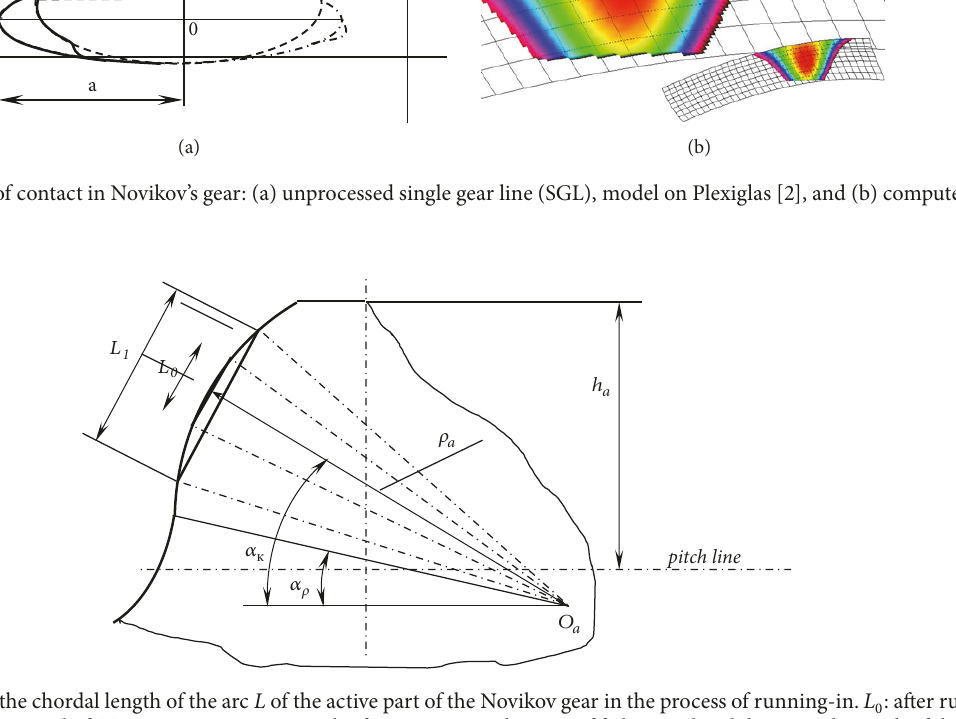
Figure 2: Changing the chordal length of the arc L of the active part of the Novikov gear in the process of running-in. L 0 : after running-in at the moment on the output shaft T 2 =1000 Nm; L 1 : as a result of running-in at the time of failure—a breakdown on the tooth of the tooth fillet at T 2 = 3550 Nm with the operating time of 7.2 ⋅ 10 6 loading cycles; 𝜌 𝛼 : radius of curvature of the tooth; 𝛼 Q : pressure angle at the theoretical contact point; 𝛼 𝜌 : the minimum angle of the profile of the active part of the